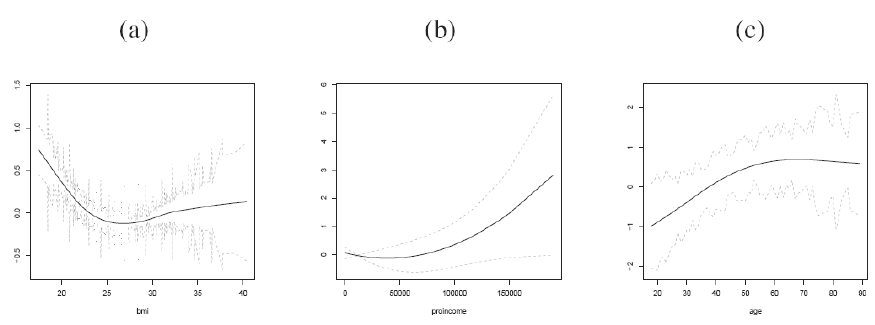
Figure 2 – Non linear contributions to the linear predictors for  (BMI in panel (a) and income in panel (b)) and  (age in panel (c)) of the final model ( M 1 ).